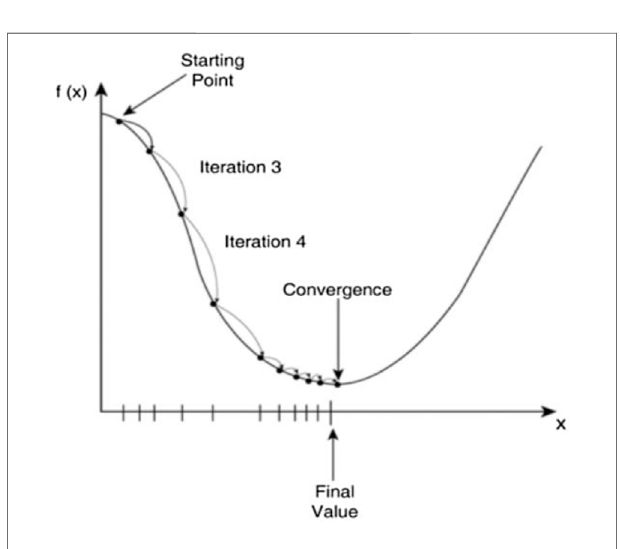
FIGURE 1 | Model training process simulation